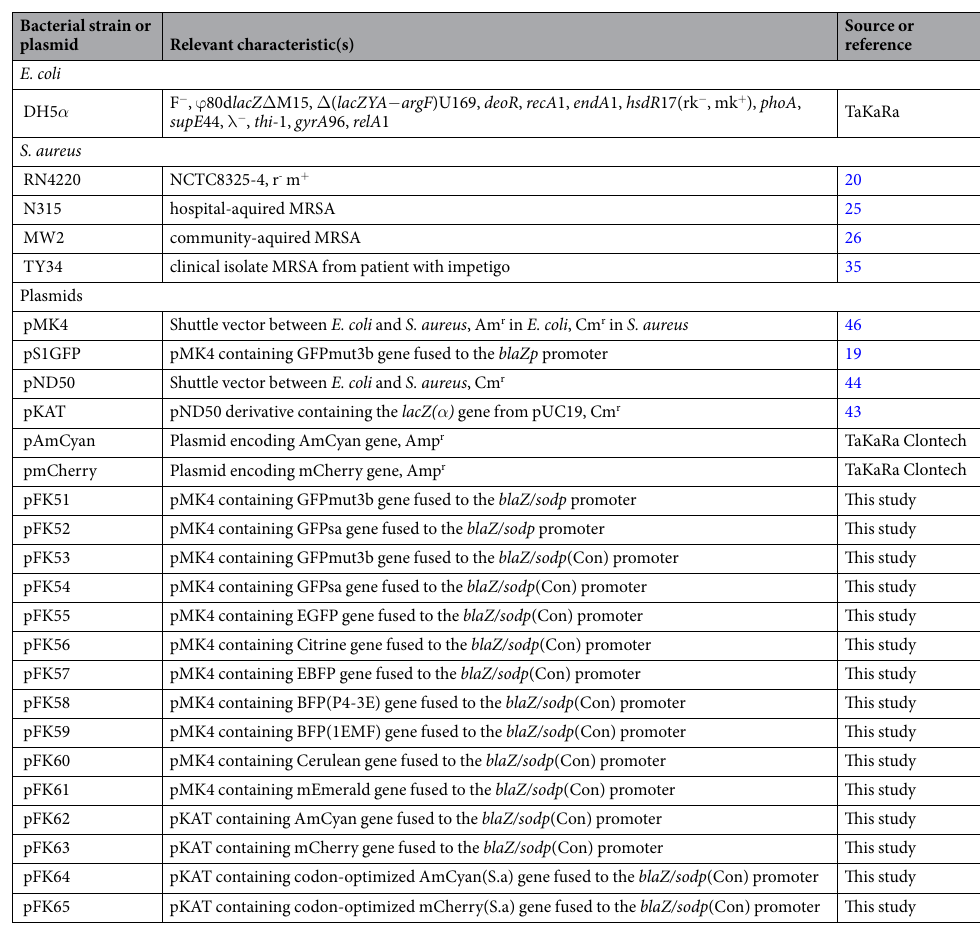
pKAT containing codon-optimized mCherry(S.a) gene fused to the blaZ/sodp (Con) promoter This study Table 1. Bacterial strains and plasmids used in this